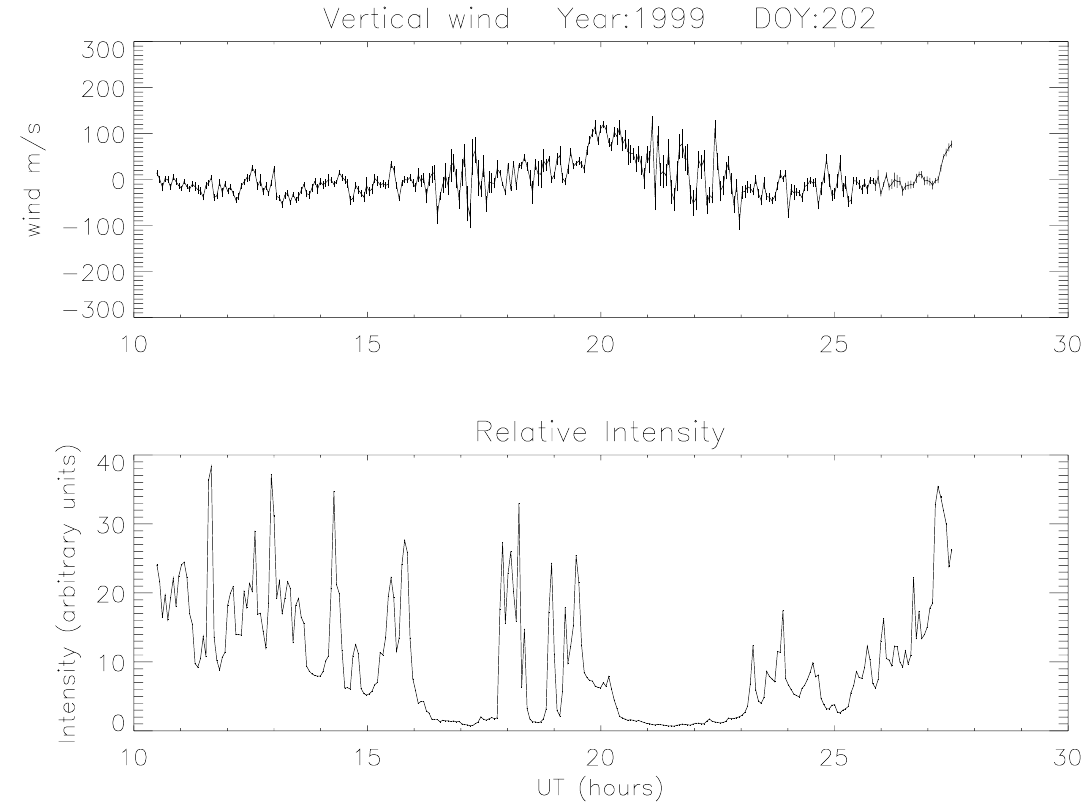
Fig. 3. FPS λ 630 nm data of wind and relative intensity from DoY